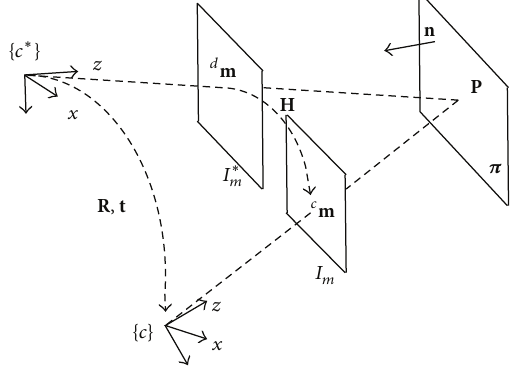
Figure 1: Projective model of the homography matrix.